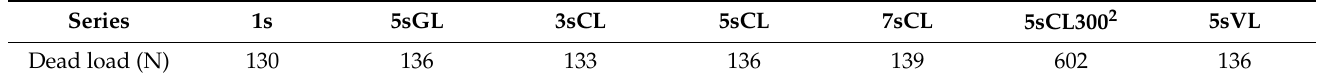
Table 4. Average dead loads of half of the specimen including steel parts from the overall setup.